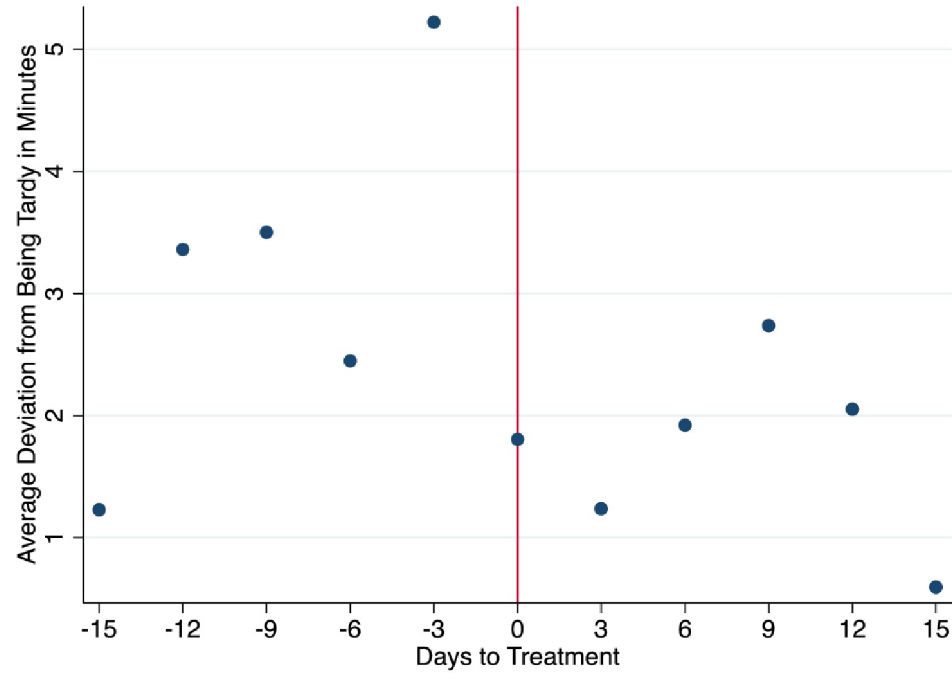
Fig 6. Before and after averages of tardiness.